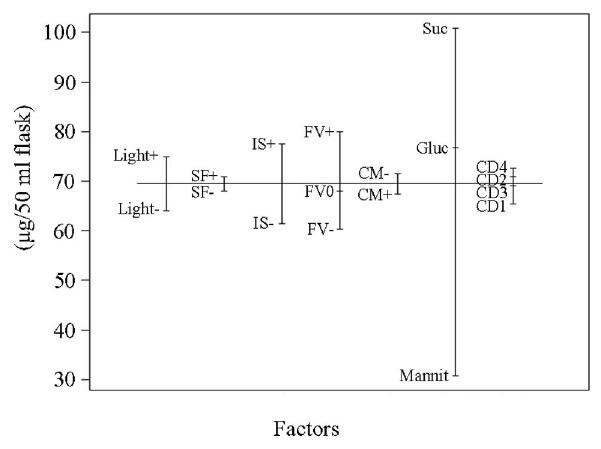
Figure 2. Geraniol yield model plot. The abbreviations are the same as in Table 1.